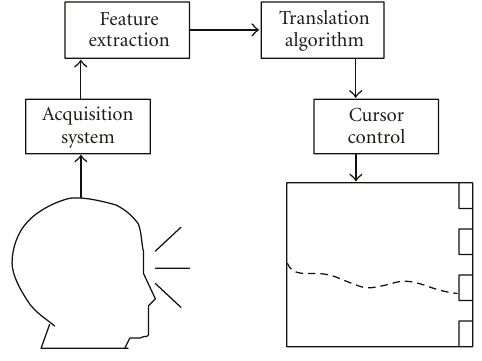
Figure 1: The diagram of EEG-based BCI system in one-dimen- sional four-targets cursor-control